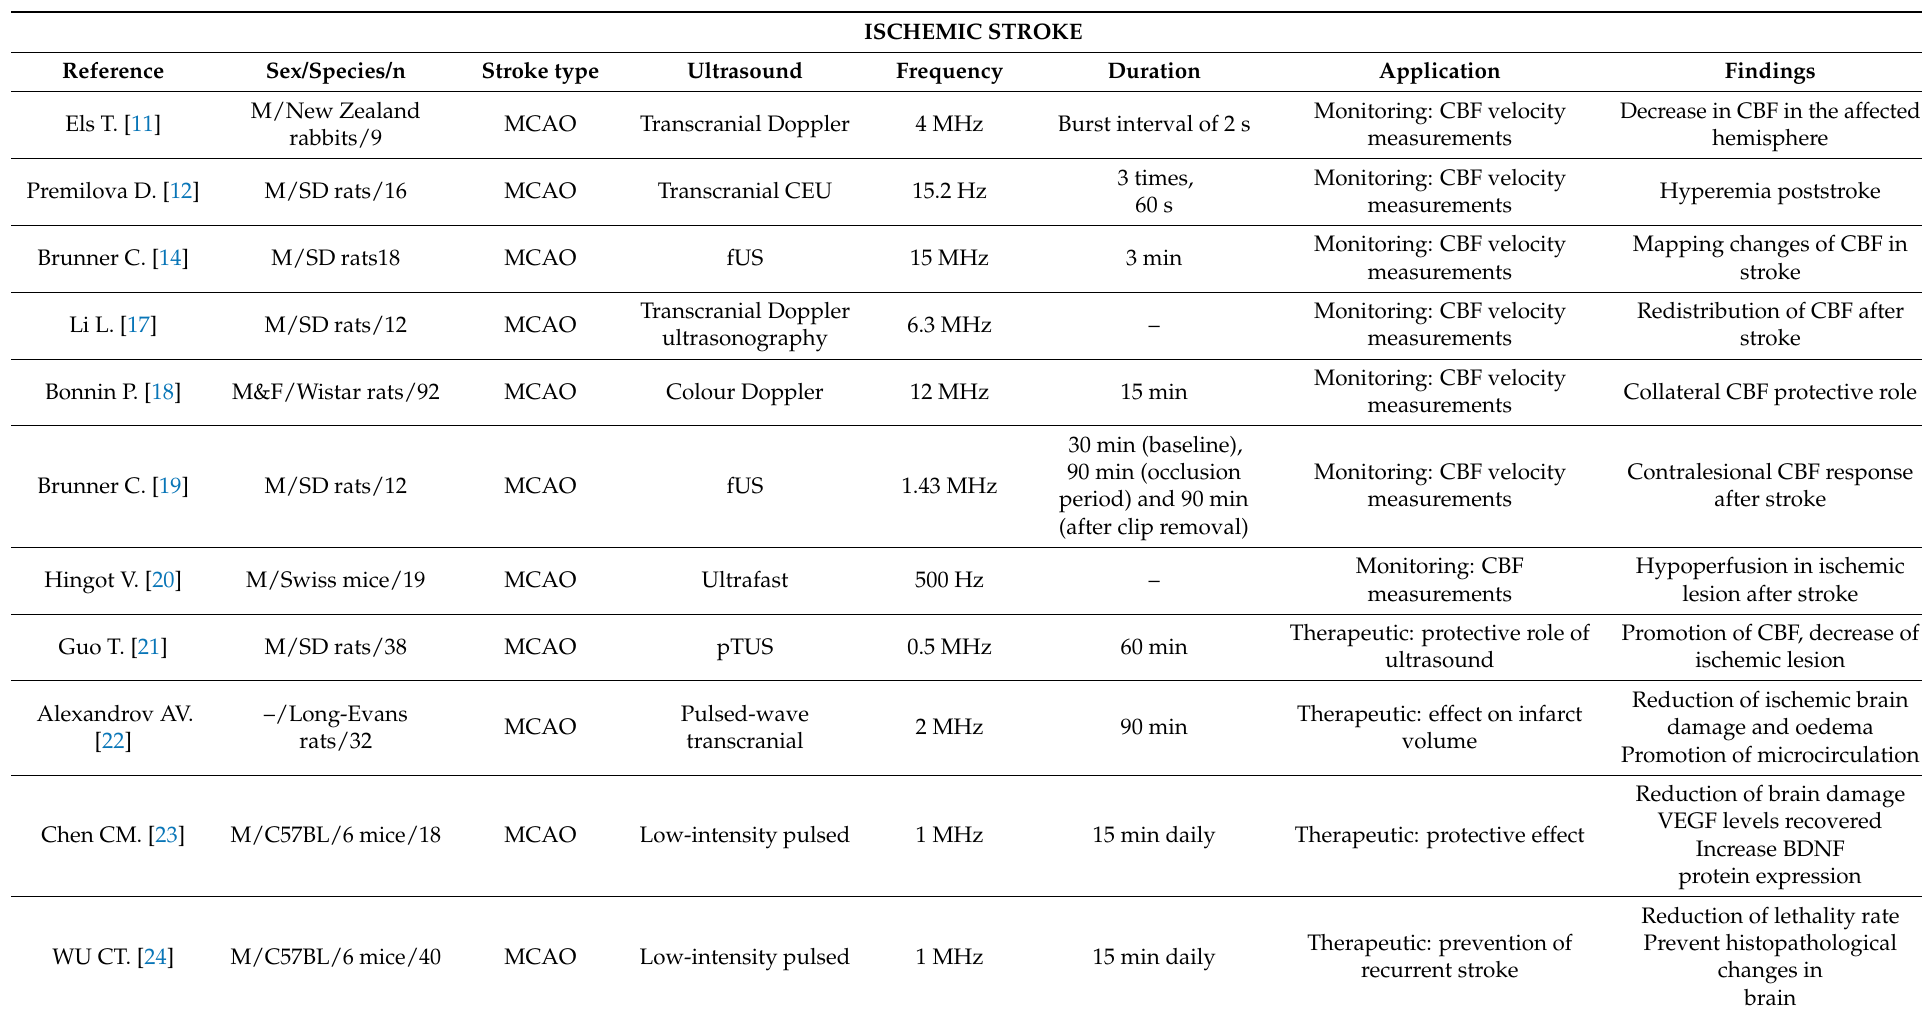
Table 1. Main experimental animal models of stroke (ischemic stroke and intracerebral hemorrhage) using ultrasound with monitoring and therapeutic